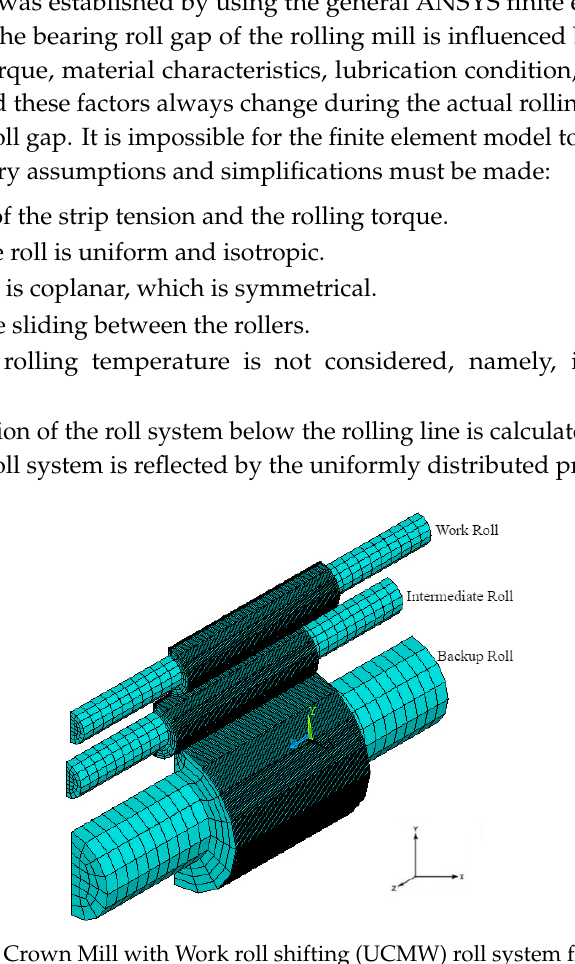
425 × 1600 Figure 2. Roll shape structure of single-sided taper work roll.